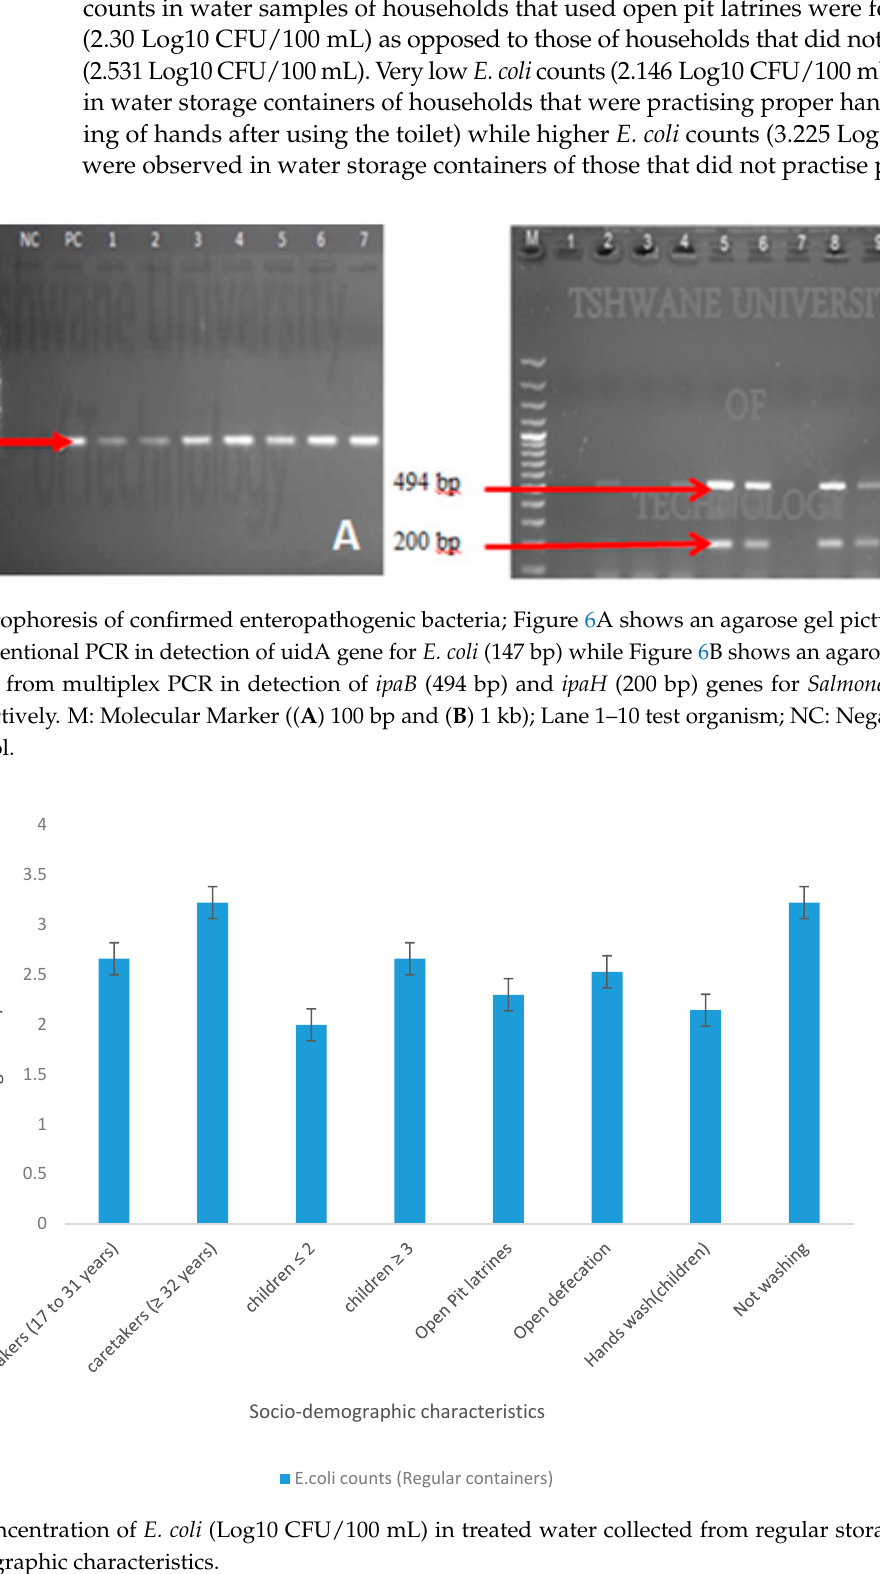
Figure 5. Mean concentration (Log 10 CFU/100 mL) of presumptive enteropathogenic bacteria from different water sources in Makwane Village.